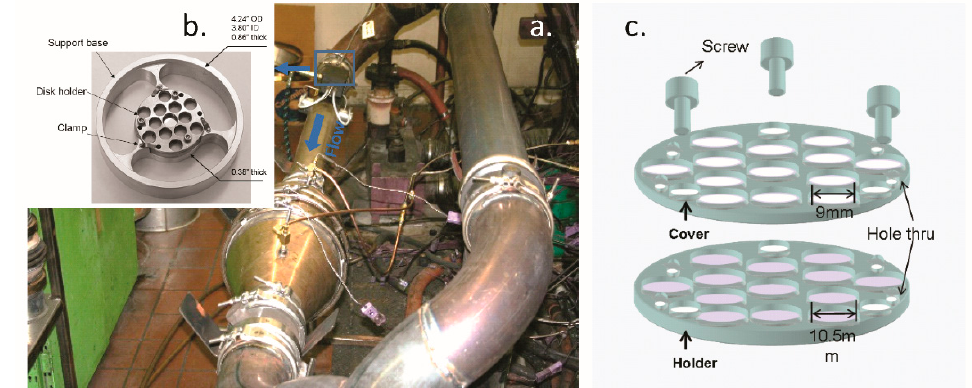
Figure 13. ( a ) layout of exhaust pipeline from engine test bench; ( b ) photograph of the sample holder being installed at the marked location of Figure 13a; ( c ) sketch showing the dimensions of TGA compatible sample holder.